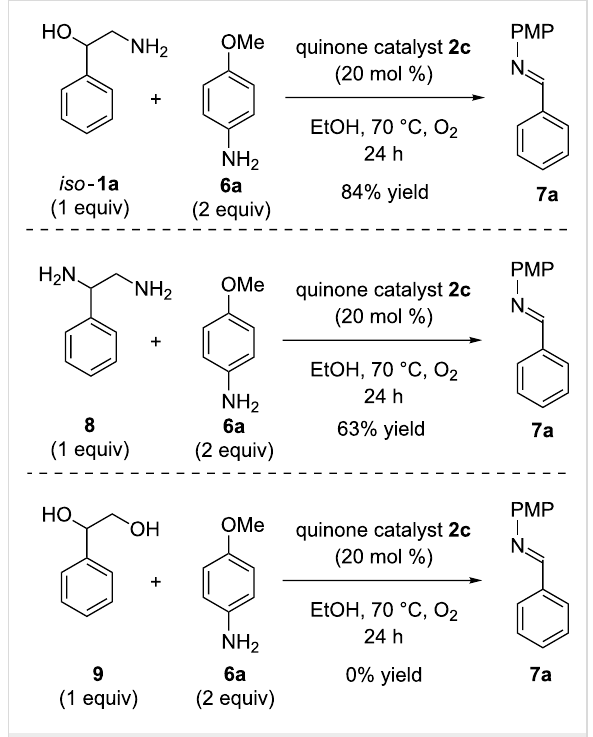
Scheme 3: Studies of quinone-catalyzed C − C bond cleavage in related